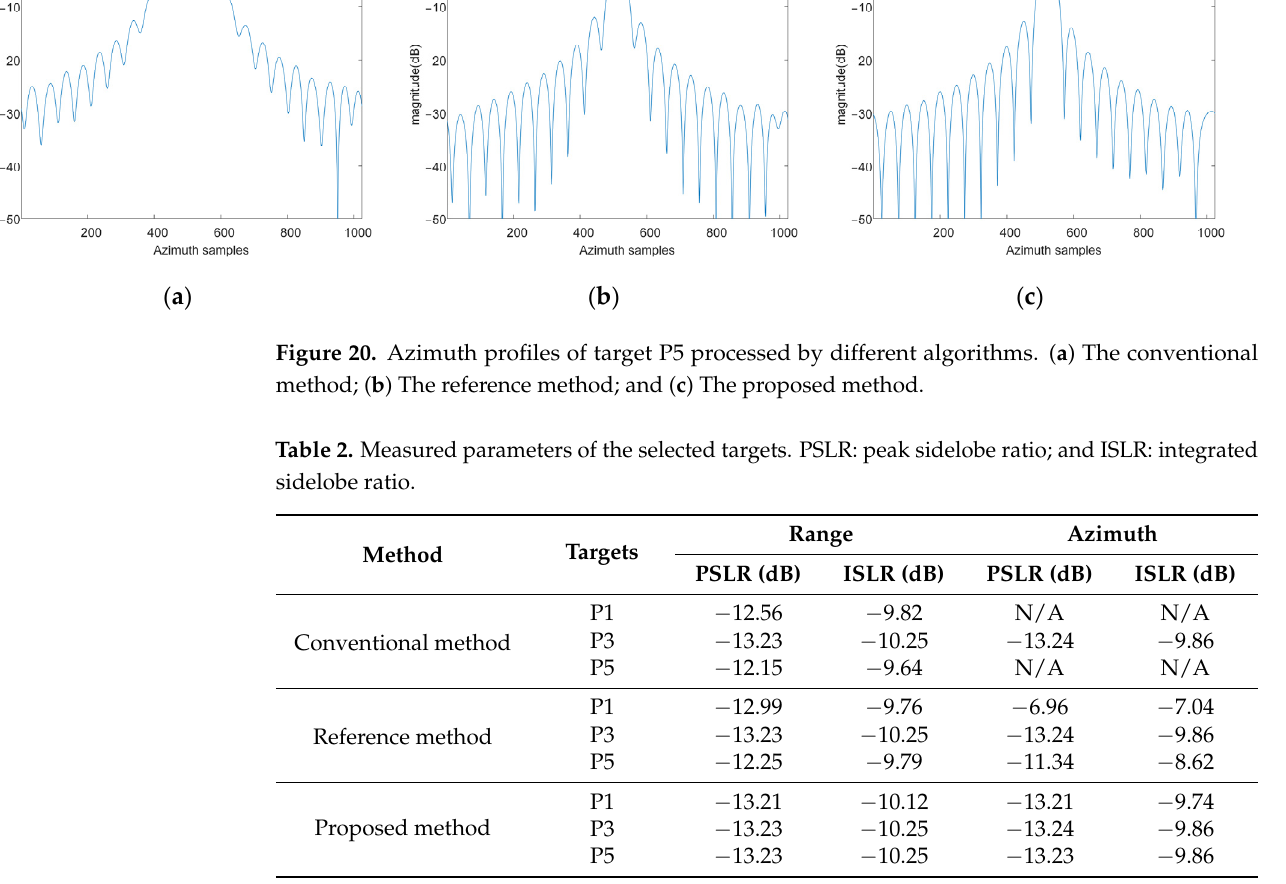
Figure 19. Range pro fi les of target P5 processed by di ff erent algorithms. ( a ) The conventional